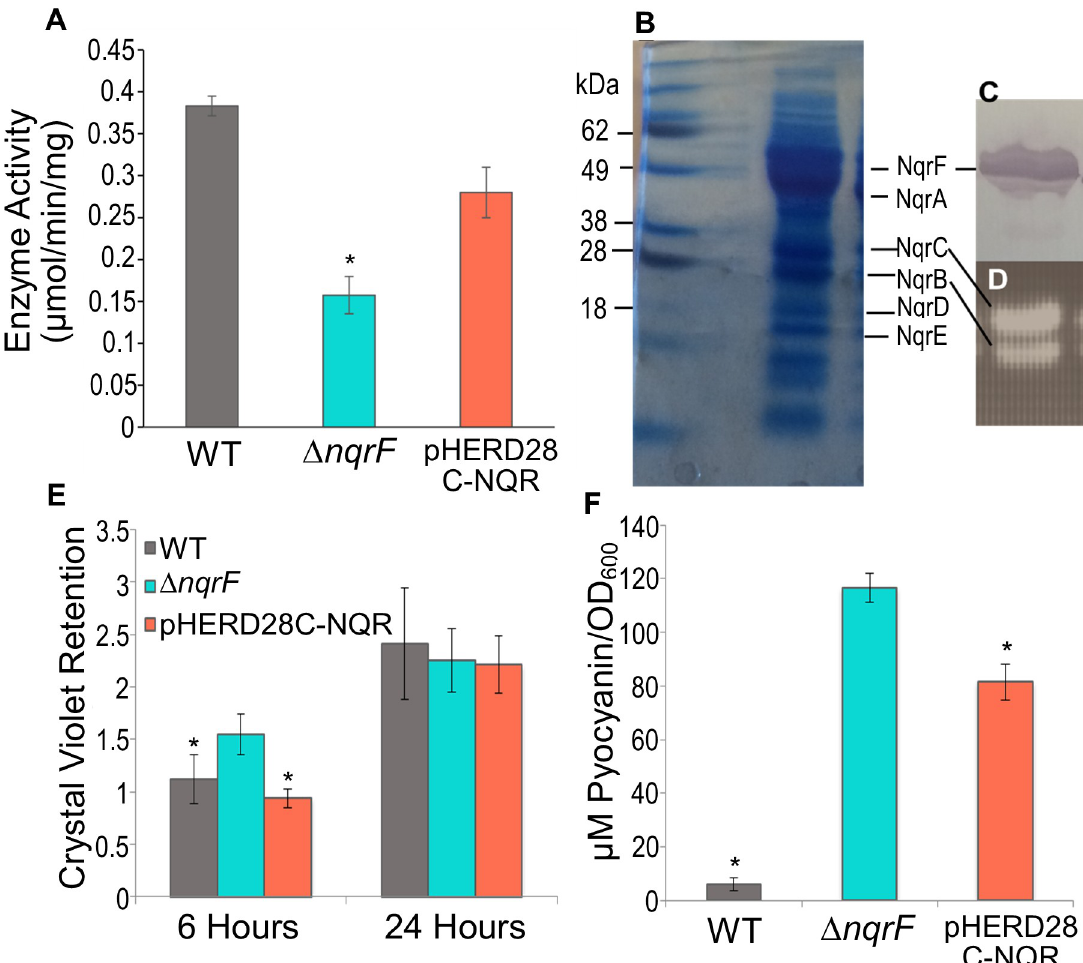
Fig 9. Complementation of NQR. A. NADH:quinone oxidoreductase activities of wild type (PAO1), Δ nqrF , and nqr -complementation strain (pHERD28C-NQR). Enzyme activity is defined as the μ moles of NADH consumed per minute per mg of membrane protein. The reaction contains: 100 μ M NADH, 50 μ M ubiquinone-1 and 100 mM NaCl. Changes in absorbance were followed at 340nm ( ε NADH = 6.22 mM − 1 cm − 1 ). and NADH dehydrogenase deletion mutants. B. SDS-gel (4–12%) of partially purified NQR complex expressed in the pHERD 28C-NQR (20 mg) run in Tris-glycine gel system stained with Coomassie Blue. C. Western blotting using anti-His5X antibodies showing the NqrF subunit, where the histidine tag is attached. D. Same gel as in (B) exposed to UV light before staining showing the fluorescent bands corresponding to the NqrB and NqrC subunits of the semi-purified NQR. E. Biofilm formation quantified as crystal violet retention at mid-attachment (6 hours) and mature (24 hours) biofilm. F. Pyocyanin concentration ( μ M) following 24 hours of growth, measured at 690 nm (4130 M -1 cm -1 ) and normalized to culture OD 600 . OD 600 of the wild type and mutant cultures were similar at each time point, ensuring that the data represent an accurate comparison of pyocyanin production between strains. Stars indicate p- values from a student’s t -test �